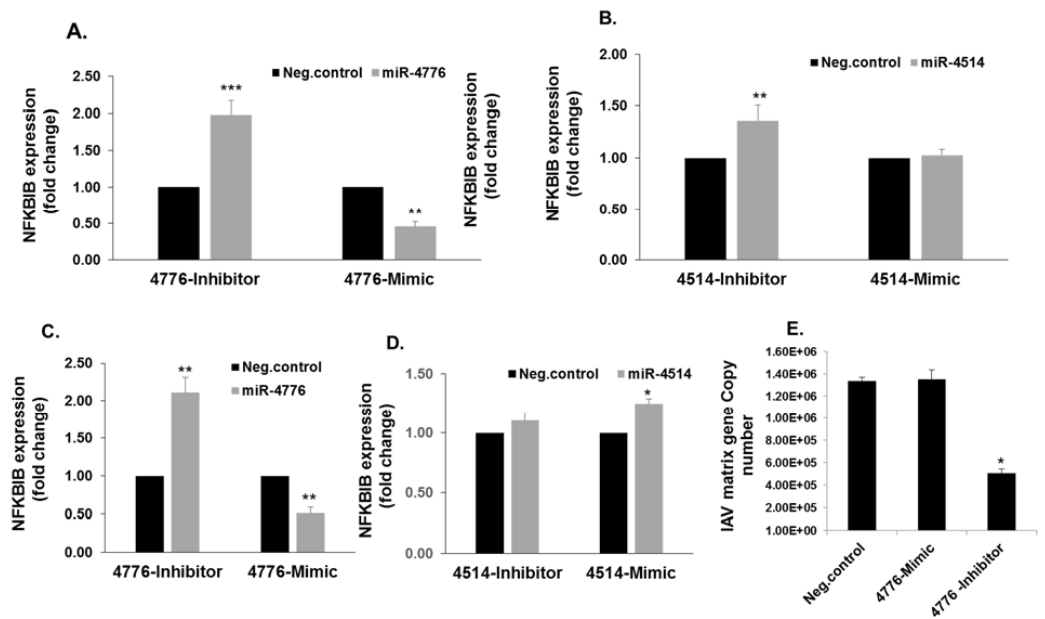
Figure 5. Downregulation of miR-4776 induce NFKBIB expression: ( A ) HBEpCs were transfected with miR-4776 inhibitor or mimic or negative control. After 48 h of incubation, RNA was extracted and converted to cDNA and used for RT-PCR. GAPDH was used as the housekeeping gene. Data are expressed as ± SEM, *** p < 0.001, ** p < 0.01 ( n = 3); ( B ) HBEpCs were transfected with miR-4514 inhibitor or mimic or the negative control. After 48 h of incubation, RNA was extracted and converted to cDNA and used for RT-PCR. The relative abundance of NFKBIB was measured in cells and the data normalized to the abundance of GAPDH. Data are expressed as ± SEM, * p < 0.05, ** p < 0.01 ( n = 3); ( C ) HBEpCs were transfected with miR-4776 mimic or inhibitor or a negative control. After 48 h of incubation, the transfected cells were either mock infected or infected with 1 MOI IAV for an additional 4 h. Relative expression of NFKBIB was analyzed by RT-PCR. Data are expressed as ± SEM, ** p < 0.01 compared the cells transfected with the negative control, ( n = 3); ( D ) HBEpCs transfected with miR-4514 mimic or inhibitor or a negative control. After 48 h of incubation, the cells were infected with 1 MOI of IAV for another 4 h. After 4 h of incubation, RNA was extracted and converted to cDNA and used for RT-PCR. The relative NFKBIB abundance was measured in infected cells, and GAPDH was used as the internal control. Data are expressed as ± SEM, * p < 0.05 compared the cells transfected with the negative control, ( n = 3); ( E ) abundance of NFKBIB modulates viral replication. HBEpCs were transfected with miR-4776 mimic or inhibitor or a negative control. Following infection, the transfected cells were infected with 1 MOI of IAV for an additional 4 h. After 4 h of incubation, RNA was extracted and converted to cDNA and used for RT-PCR. Matrix copy number in cells transfected with either miR-4776 mimic or inhibitor or negative control is shown. Data are expressed as ± SEM, ** p < 0.001 ( n =